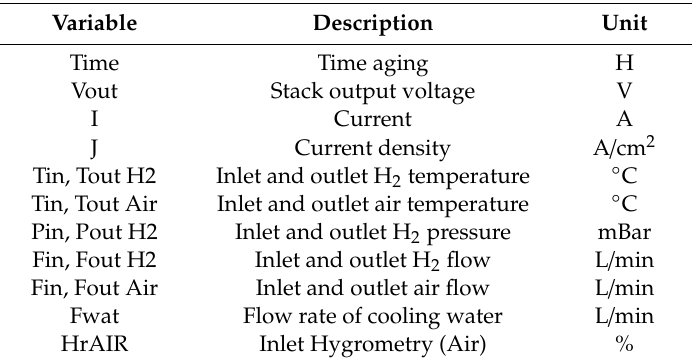
Table 1. Variables monitored.